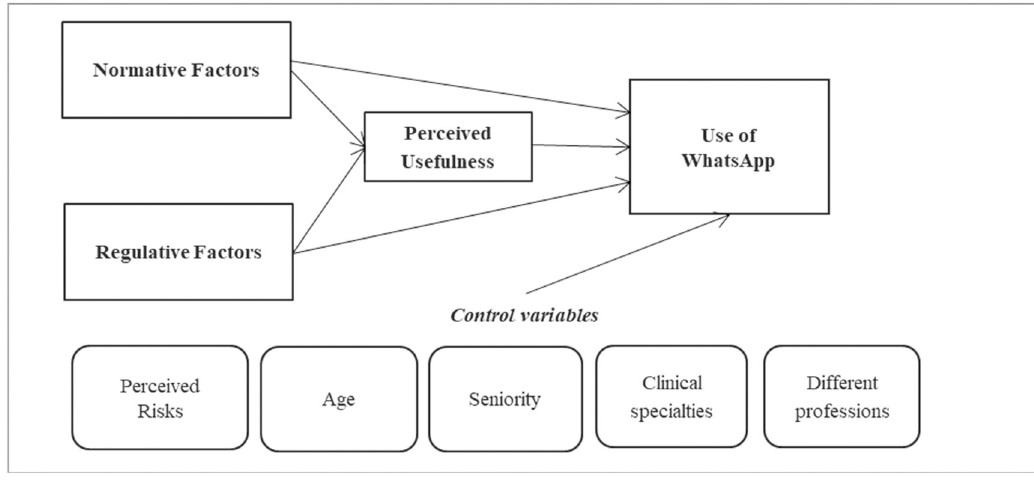
Fig 1. Theoretical